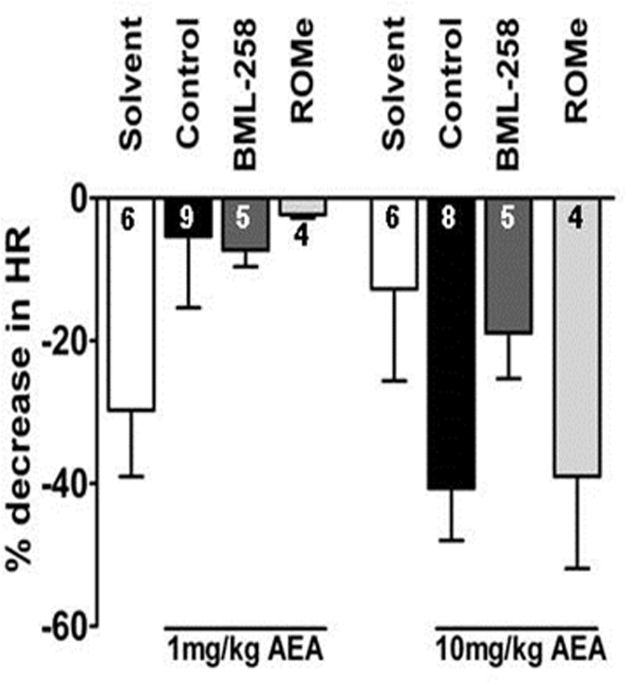
Variable bradycardic response during phase 1 hypotension. Mice were pre-treated with either DMSO, (control) BML-258 or ROMe (both 75 mg/kg) and anaesthetised with isoflurane. The %-decrease from pre-injection values for HR during the initial hypotension in response to 1 and 10 mg/ml AEA or the equivalent amount of tocrisolve solvent was quantified for the different treatment groups. Data are expressed as mean ± S.E.M. Numbers in the bars denote n-numbers. P = ns for comparisons made with the control group.